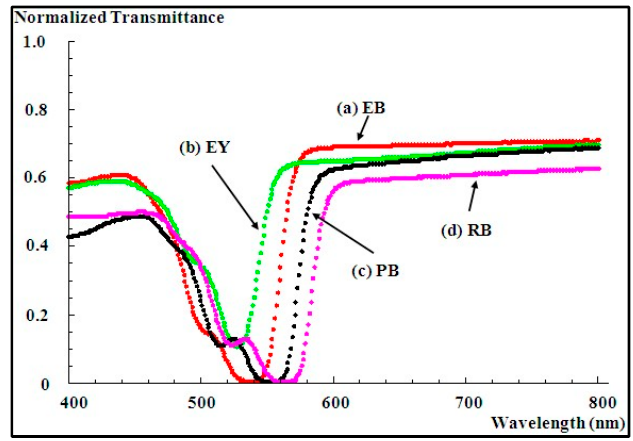
Figure 2. Normalize transmittance spectrum for four different photosensitizers ( a ) EB (red curve); ( b )